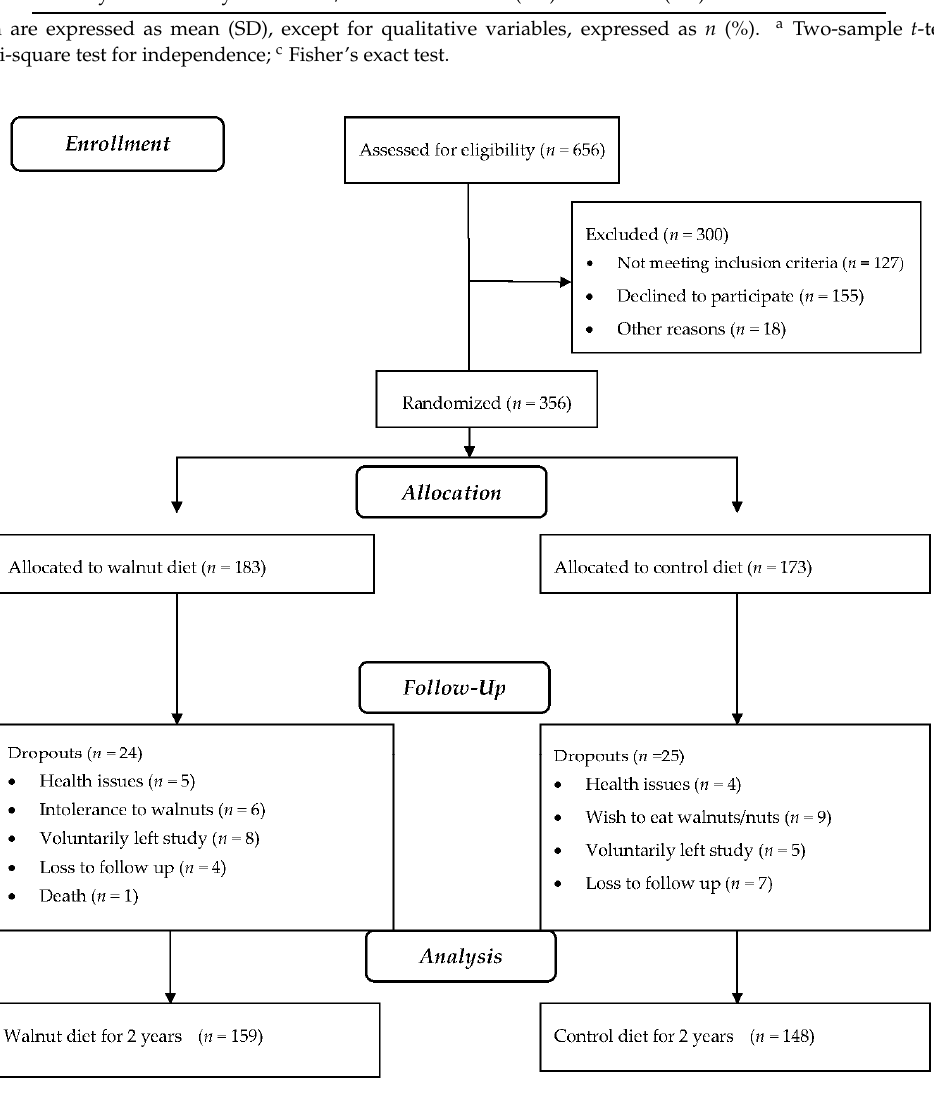
Figure 1. Study flowchart.